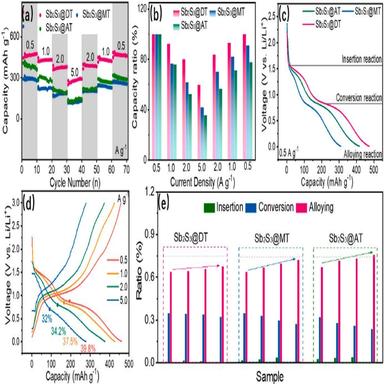
Rate performance(a), capacity retention(b) of the as-fabricated samples at 0.5, 1.0, 2.0 and 5.0 A g− 1 (1C = 1000 mAh g− 1 ). The charge/discharge platforms of as-prepared samples during the first cycles(c). The charge/discharge platforms of Sb2S3@DT during the first cycles at different current densities (d). The discharge capacity contribution of as-prepared samples.